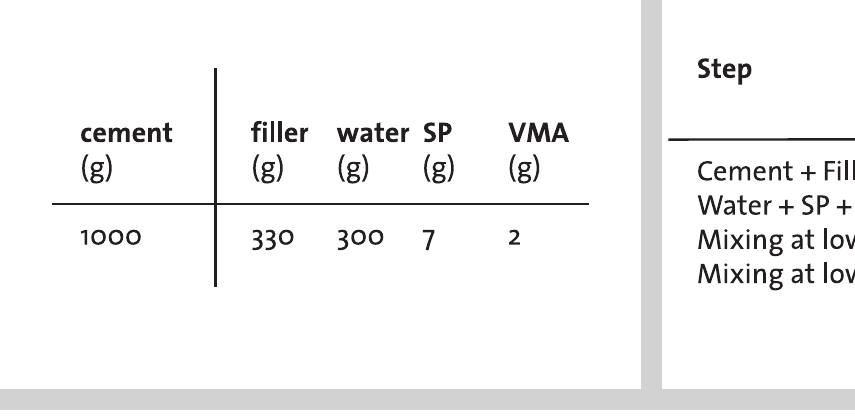
Table 1 (left): Composition of the cement paste [6 - 7]. Table 2: Mixing